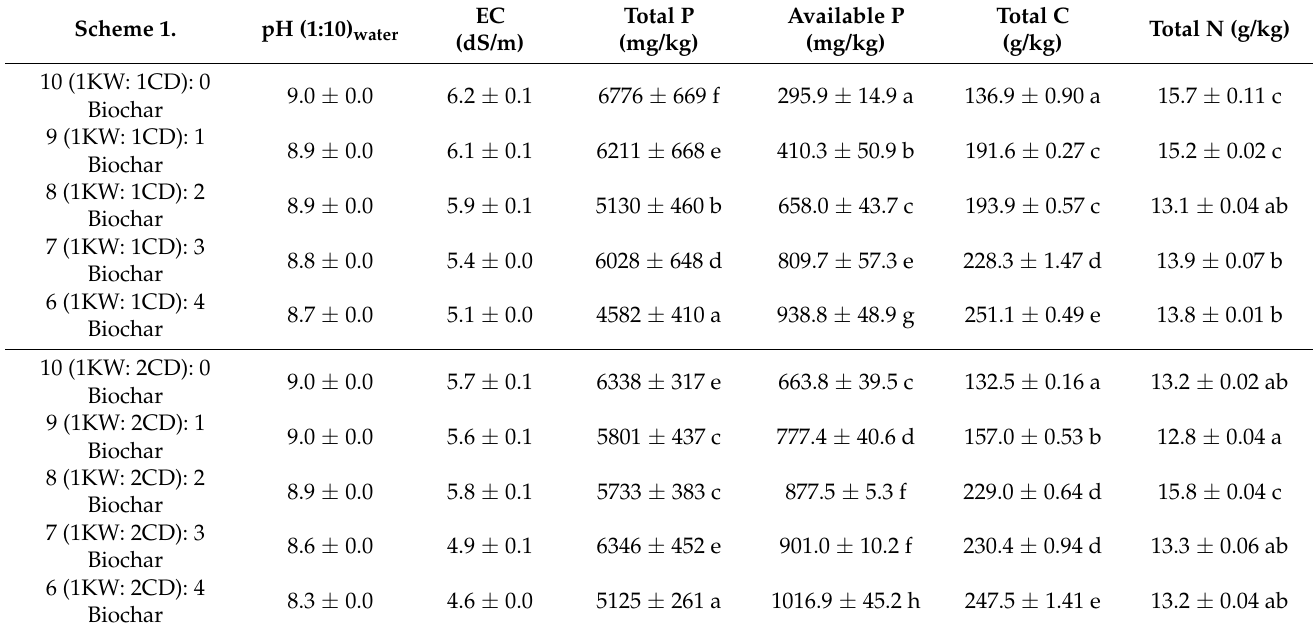
Table 1. Selected characteristics of the biochar-compost mixtures (dry